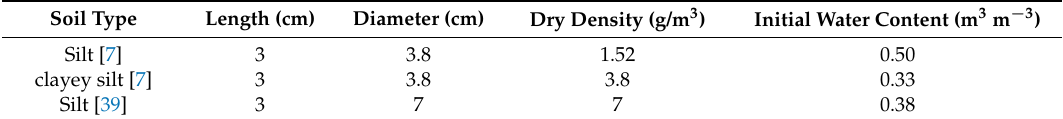
Table 1. Physical parameters of the soil samples.